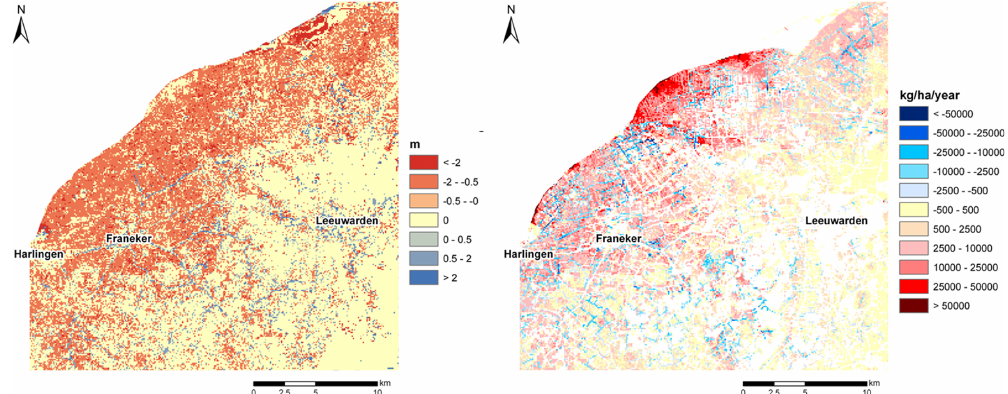
Fig. 24. Left panel: decrease (red) and increase (blue) of the fresh water lens thickness in the climate W+ and sea level rise scenario compared to the autonomic scenario. Right panel: salt load increase (red) and decrease (blue) due to climate W+ and sea level rise in comparison with the autonomic